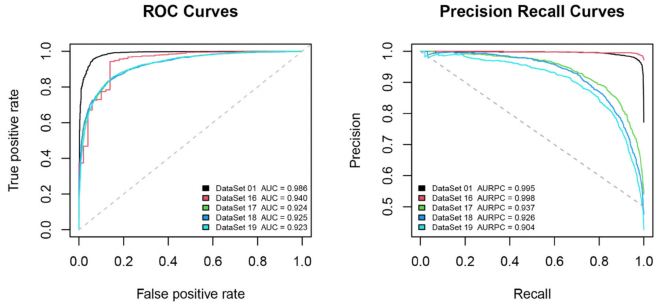
Figure 12. Recall-precision and ROC curves displaying the performance of LightGBM on testing datasets of DataSet 01, DataSet 16, DataSet 17, DataSet 18 and DataSet 19. Note that the scale of values on the vertical axis is di ff erent from recall-precision curves (0.5–1.) and ROC curves